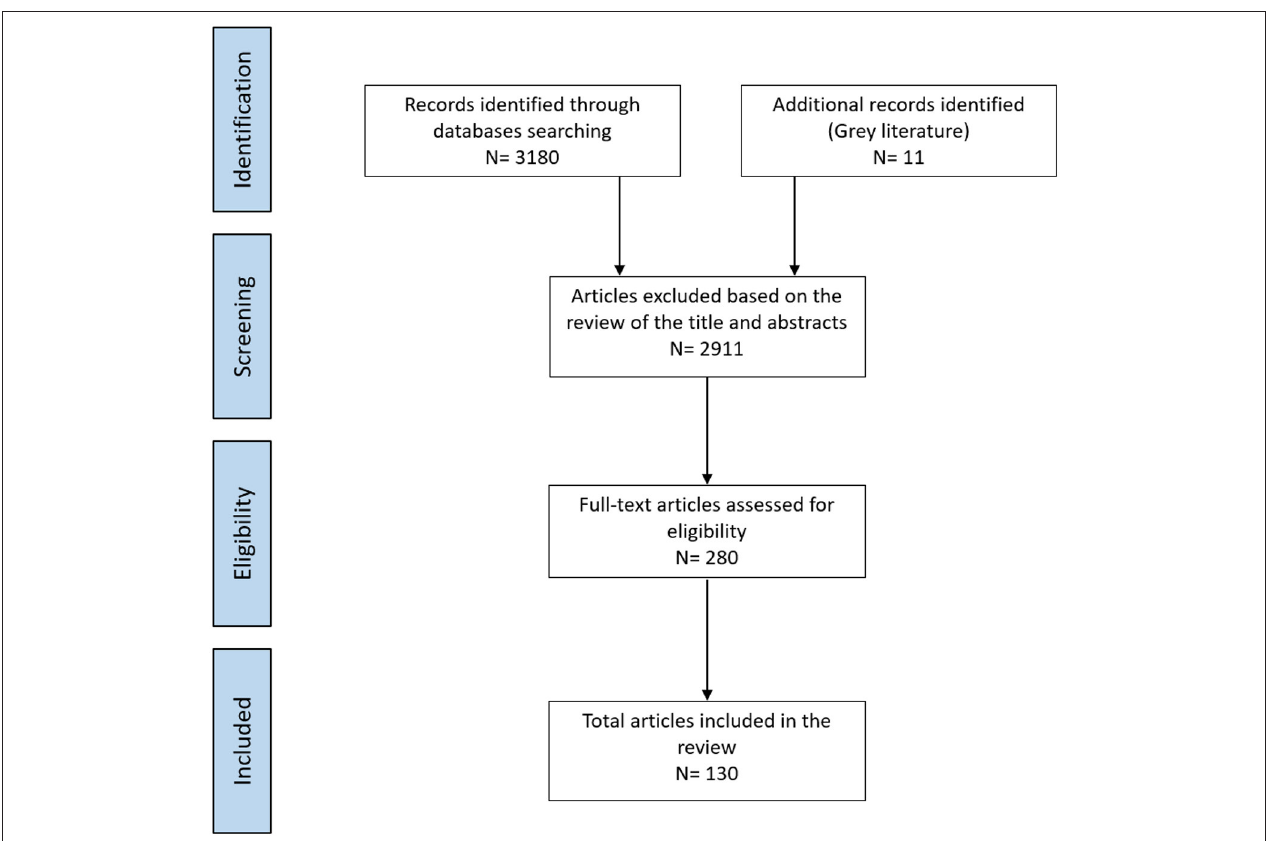
FIGURE 1 | Flow diagram of studies through the